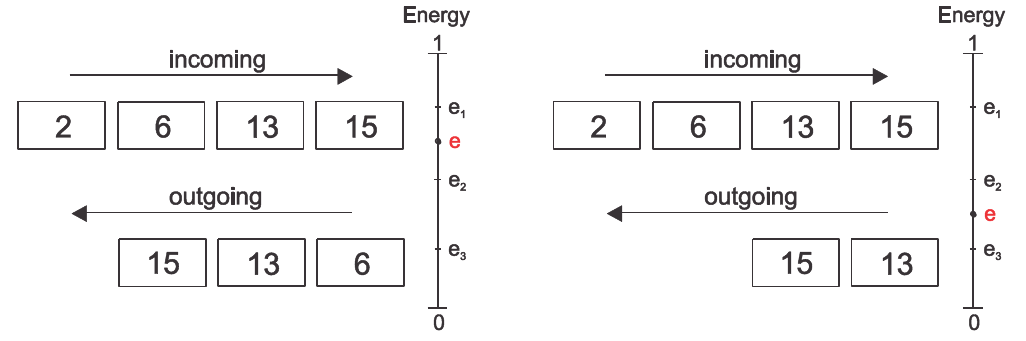
Figure 2. Threshold-based packet relaying regarding the sensing relevancies of source